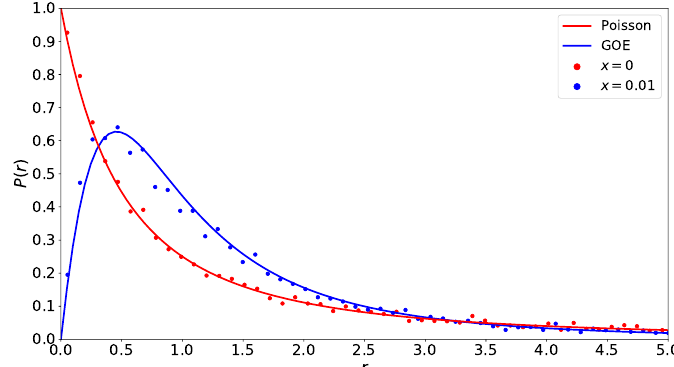
Figure 16: Probability distribution of the ratio r of consecutive energy level spac- = ( E − E ) / ( E − E ) , for a large (9856-dimensional) Hilbert space ings, r n n + 1 n n n − 1 fragment of the model (16) on a 6 × 6 lattice with p.b.c, for two values of parameter x : (red) no disorder, x = 0, (blue) small disorder, x = 0.01. Solid lines corre- spond to distributions of r for (red) Poisson ensemble, P ( r ) = ( 1 + r ) − 2 , (blue) GOE, r + r 2 P ( r ) = 27 (surmise from Ref. [ 70 ] ). ( 1 + r + r 2 ) 5 / 2 8